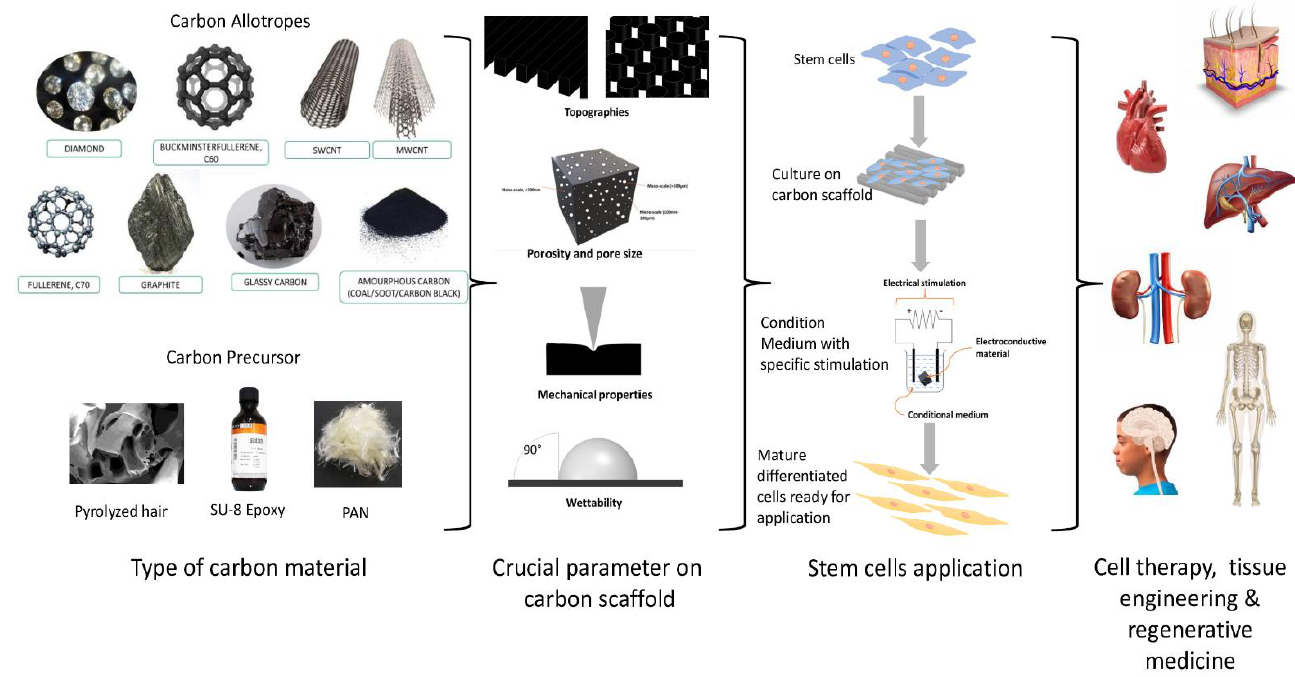
Figure 1. Schematic illustration of carbon material application.